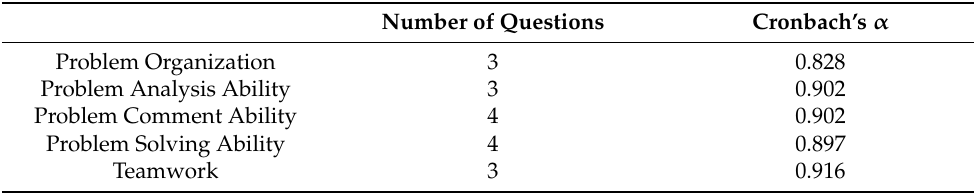
Table 2. Cronbach’s α of the question in the questionnaire